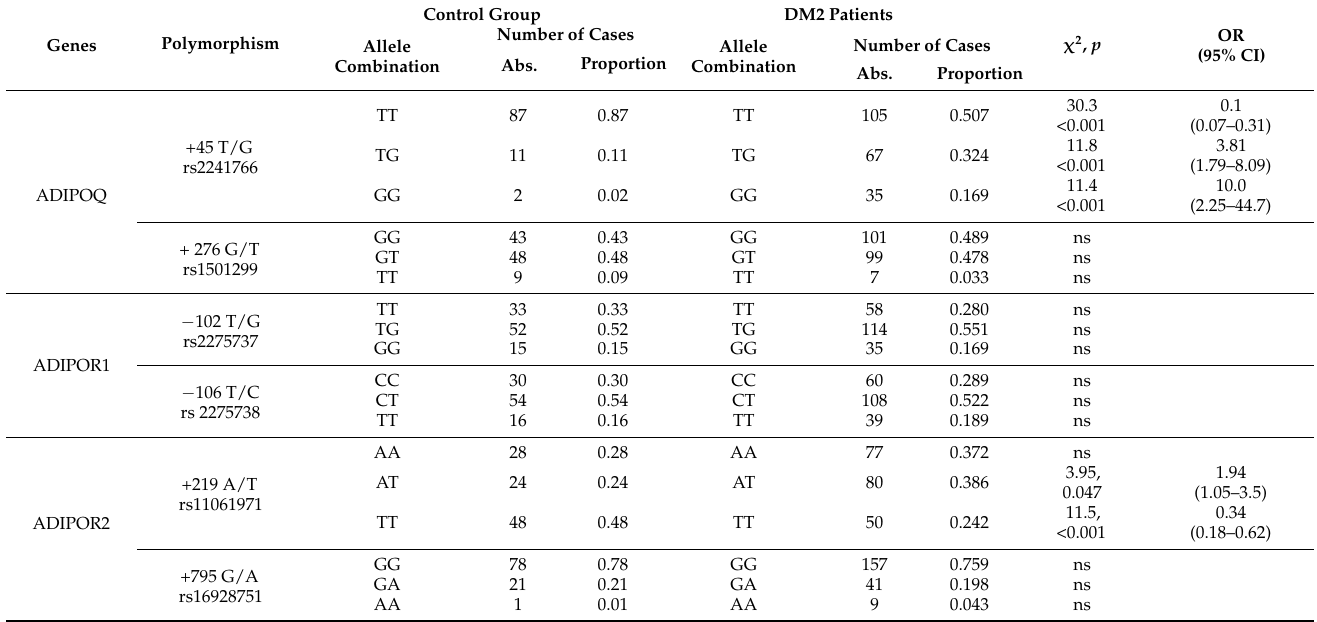
Table 2. Adiponectin genes, receptor alleles, and frequency of distribution of genotype polymorphism in patients with diabetes